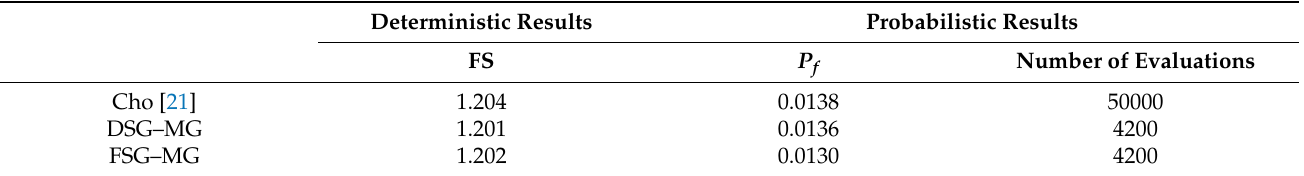
Table 2. Comparisons of the deterministic and probabilistic analyses